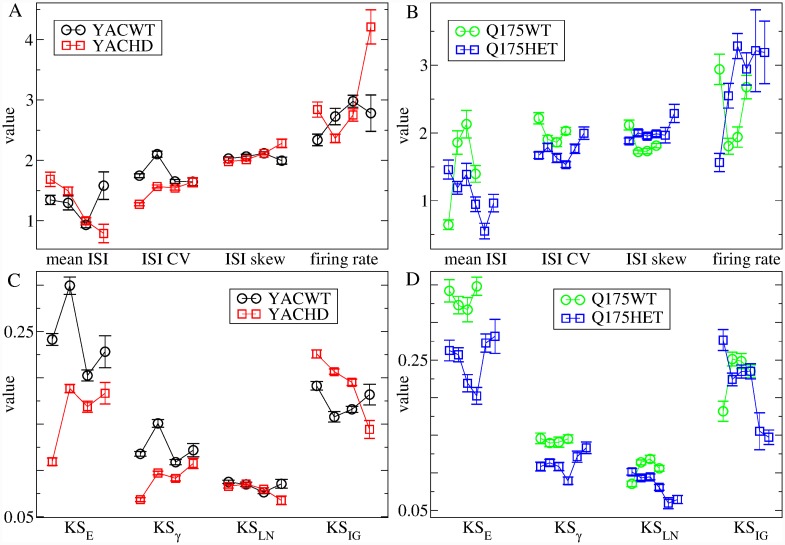
ISI statistical quantities calculated from experimental spike trains divided into distinct age intervals.(a,c) YACWT (black circles) and YACHD (red squares) spike trains are divided into four 23 week intervals, 0-23, 23-46, 46-69, and over 69 weeks. (b,d) Q175WT (green circles), spike trains are divided into four 10 week intervals, 20-30, 30-40, 40-50 and 50-60 weeks. Q175Het (blue squares), spike trains are divided into six 10 week intervals, 20-30, 30-40, 40-50, 50-60, 60-70 and 70-80 weeks (see Methods). (a,b) mean ISI μ, ISI CV σ/μ, ISI rescaled skew S/CV (labelled ‘ISI skew’), firing rate, r. (c,d) KS distance between the data and four maximum likelihood distributions, exponential, KSE, gamma, KSγ, log-normal, KSLN, and inverse-Gaussian, KSIG. Values shown are averages of the given quantity across all the spike trains in the particular dataset and bars show SEM (see Methods).